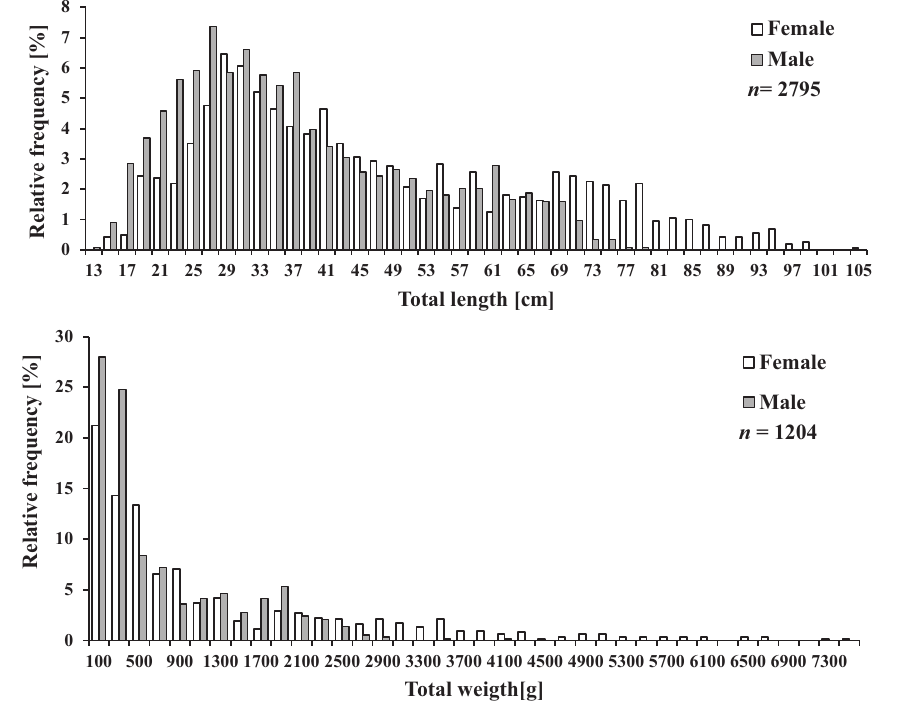
Figure 3. Length and weight frequency distribution by sex of Pacific hake, Merluccius productus , in the Gulf of California during research cruises from 2014 to 2019. Table 2. Total length–total weight relation of the Pacific hake, Merluccius productus , in the Gulf of California.